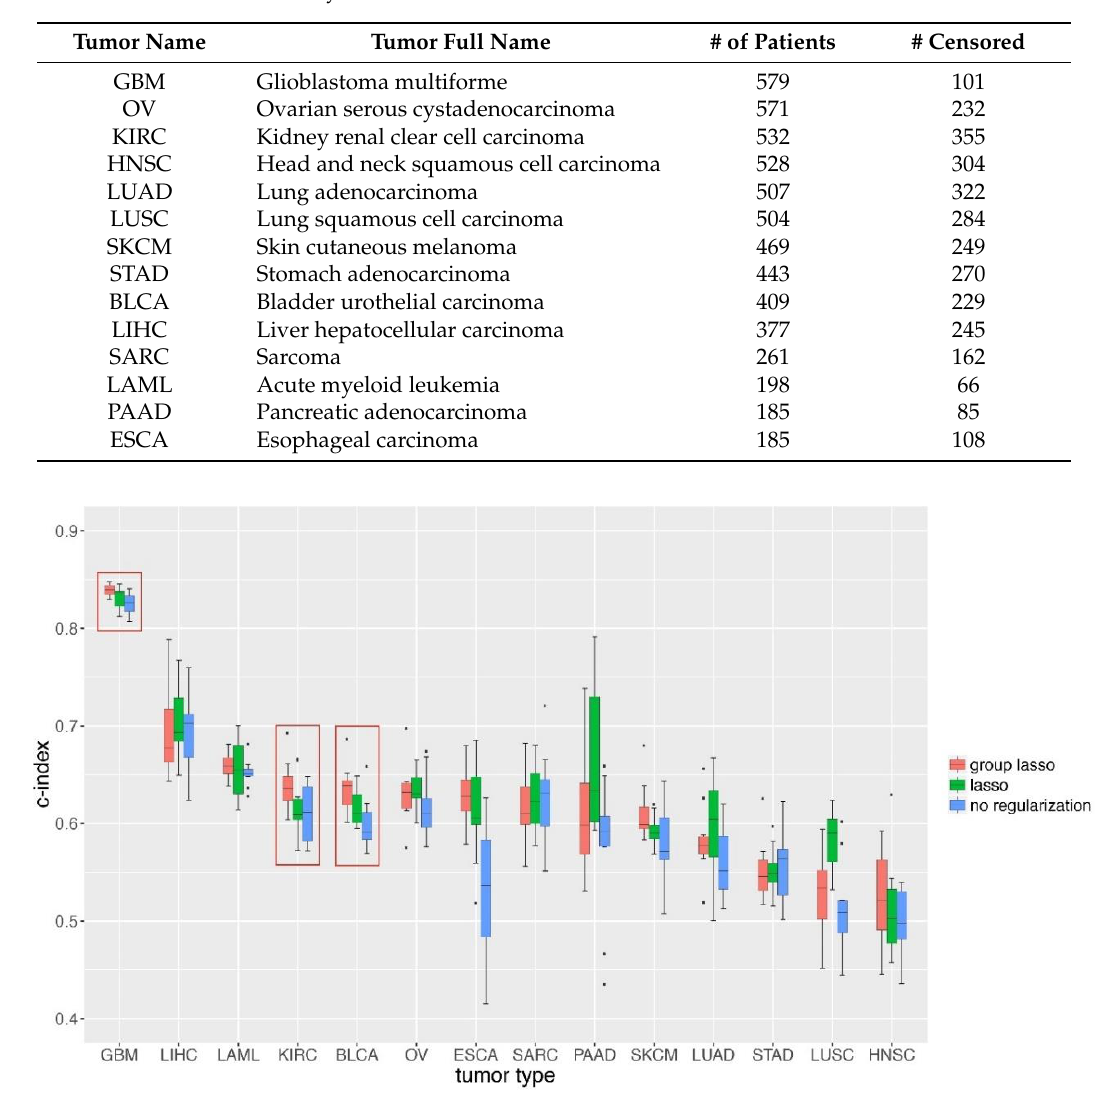
Table 1. Summary of the selected TCGA datasets. Only the TCGA tumor types with a ratio of non- censored over censored of no less than 0.3 and the number of patients no less than 100 were considered in the GDP analysis.